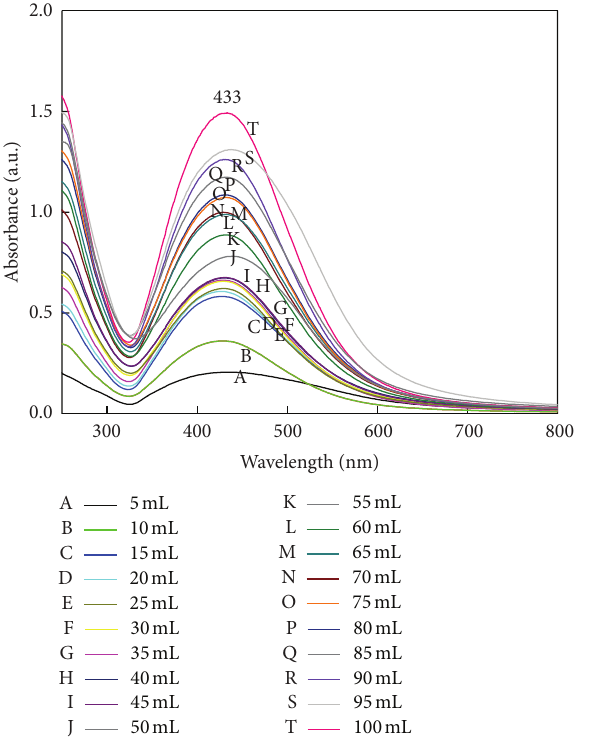
Figure 11: Effect of salt concentration on synthesis of SNPs. UV-Vis extinction spectra show maximum surface plasmon absorbance in 2 mM (T) concentration of SNPs. Synthesis of SNPs is proportional to salt concentration (treatment of 1.5mM AgNO 3 gives maximum synthesis of SNPs as compared with 2 mM AgNO 3